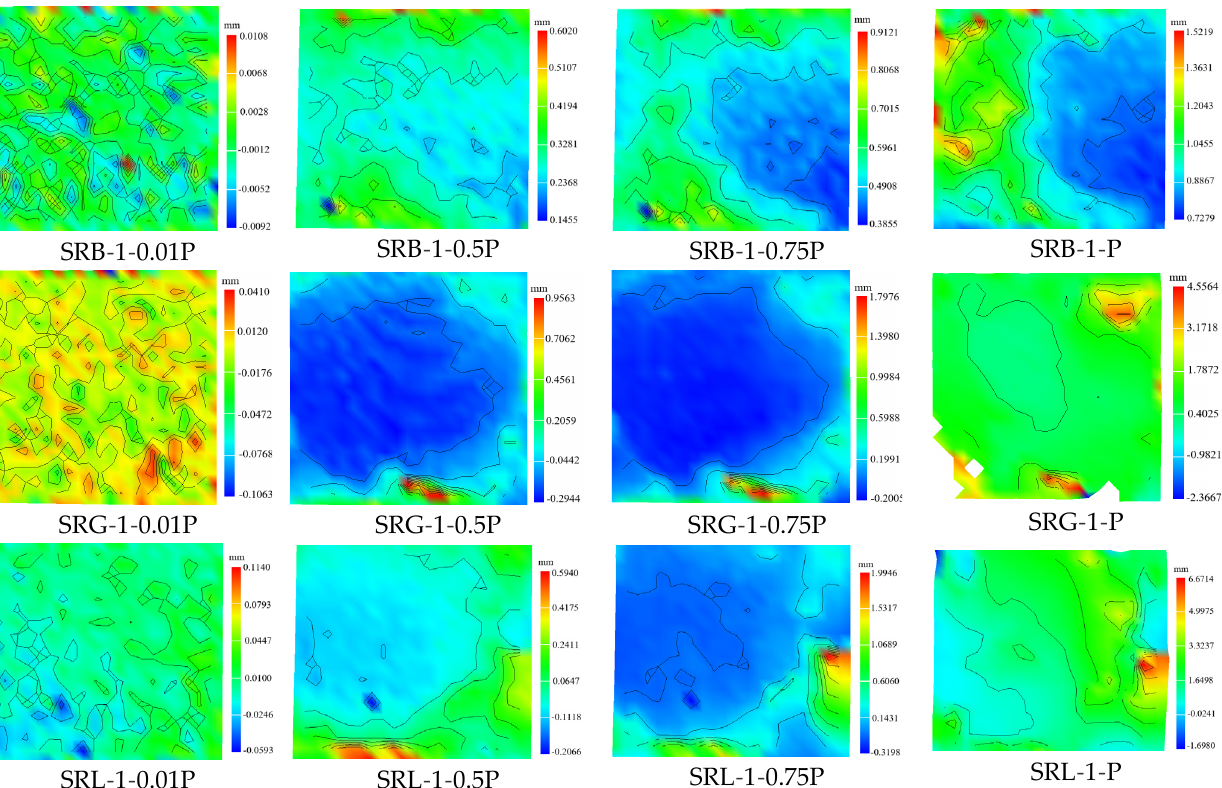
Figure 6. Major strain cloud diagrams of rock specimens.